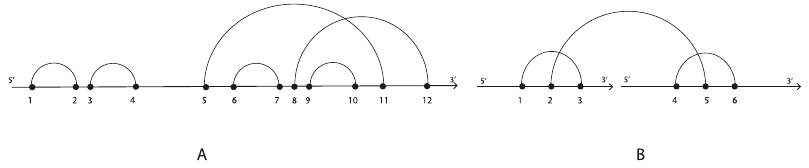
Figure 3: The core of the structures shown in Figure 1.